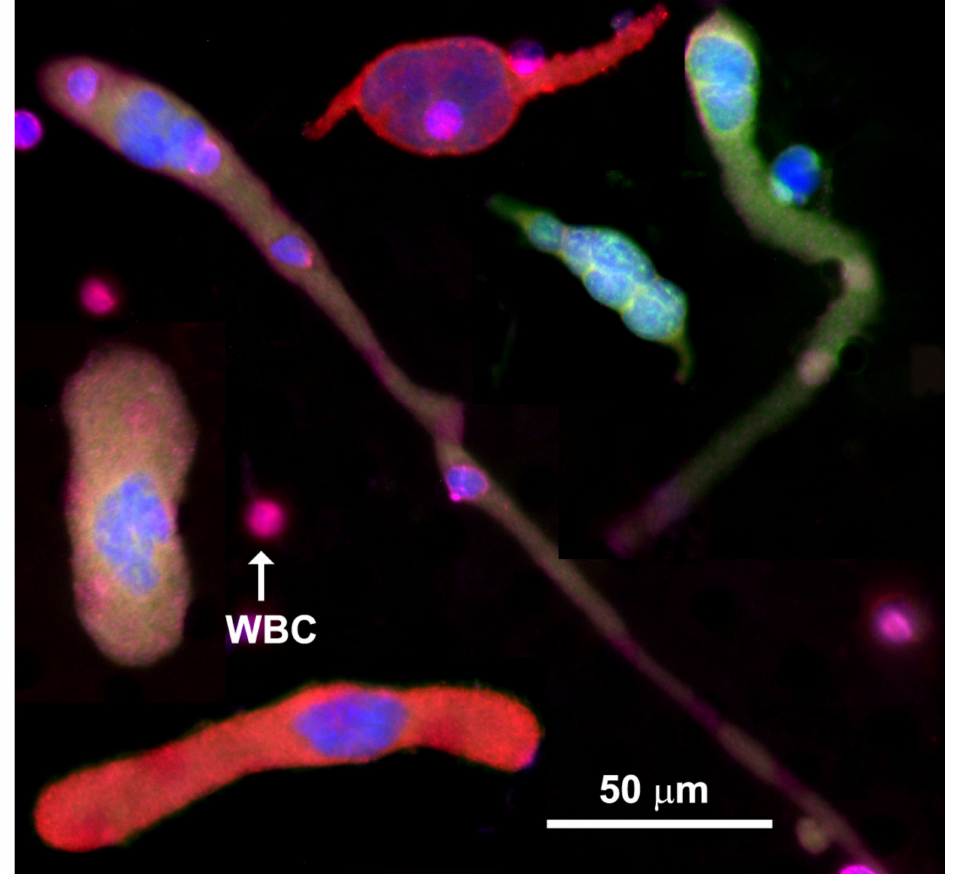
Figure 2. Even though every CAML has a different morphology, CAMLs have a few common features: a single tail or two tails on the opposite sides of the cell, and rod, oval or round shapes. CAMLs are polynucleated. DAPI (blue), CK8, 18, 19 (green), PD-L1 (red), and CD45 (violet). The scale is 50 µ